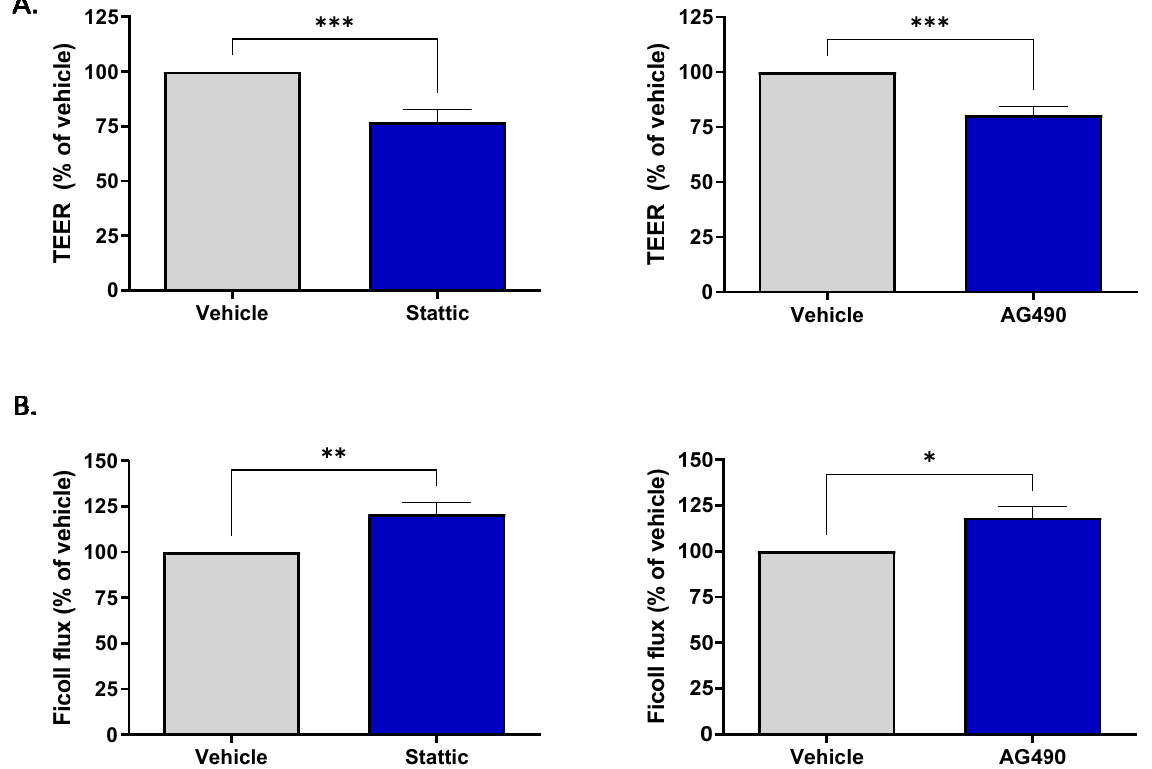
Figure 4. Inhibition of STAT3 reduces barrier integrity of brain microvascular ECs. ECs were incubated with Stattic (1.25 µ M) or AG490 (12.5 µ M) for 12 h following which barrier integrity was assessed by transendothelial electrical resistance (TEER) and flux of FITC-Ficoll 70 across the monolayer. Treatment with either inhibitor reduced the electrical resistance across the monolayer ( A ) Stattic n = 11; AG490 n = 10, and increased permeability to Ficoll 70 ( B ), Stattic n = 6, AG490 n = 6; *, p < 0.05; **, p < 0.01; ***, p < 0.001, t-test. Data are presented as mean ± SEM.